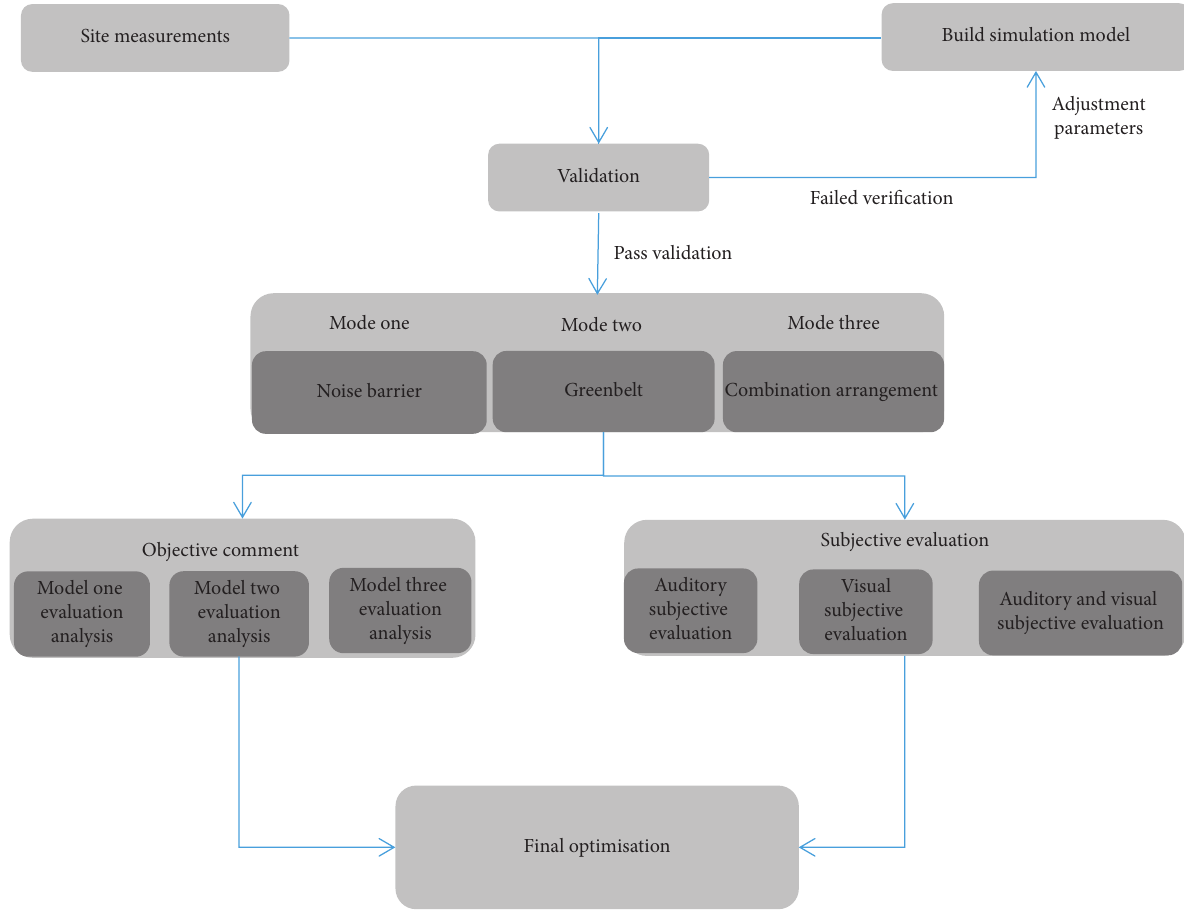
Figure 3: Technology